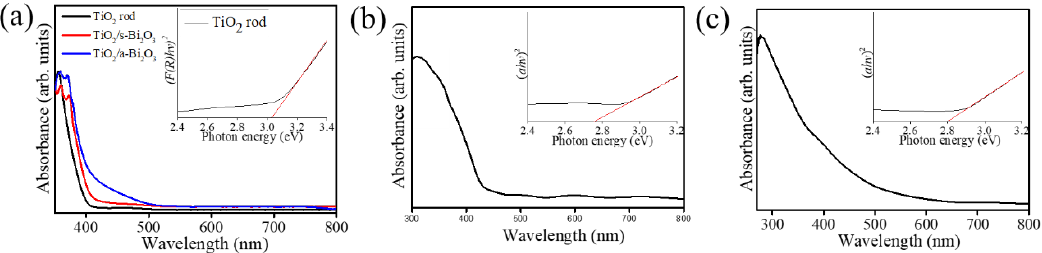
Figure 6. ( a ) Absorbance spectra of various rod samples. ( b ) Absorbance spectrum of the s-Bi 2 O 3 thin film. ( c ) Absorbance spectrum of the a-Bi 2 O 3 thin film. The insets show the bandgap of the TiO 2 rods, s-Bi 2 O 3 film, and a-Bi 2 O 3 film.